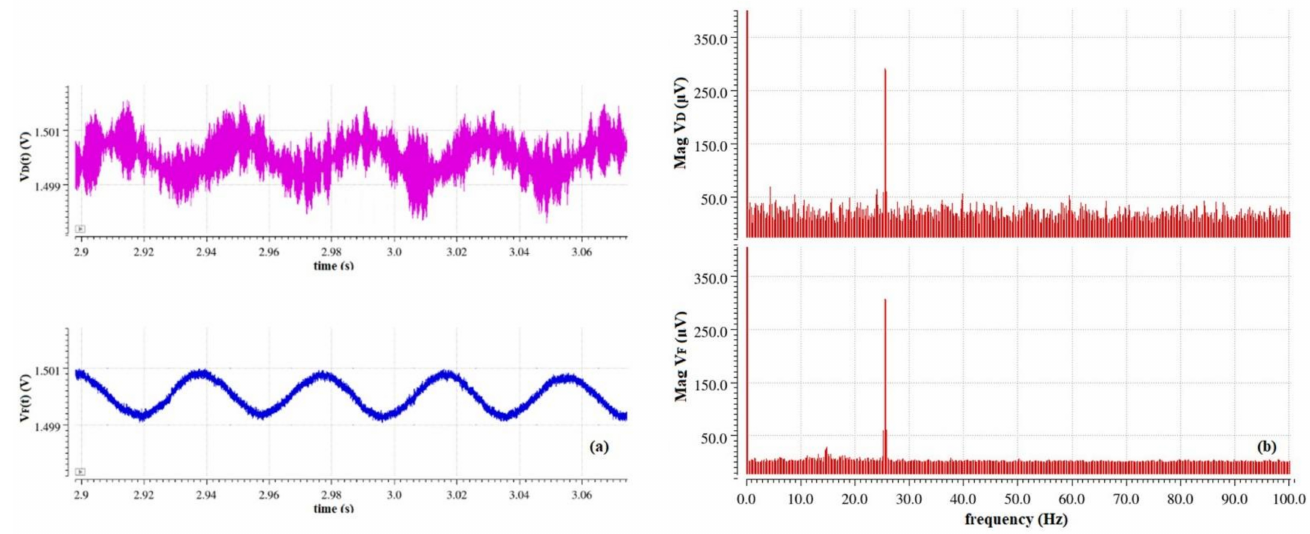
Figure 12. ( a ) Transient noise simulation of signal after I-V conversion and after filtering for E = 10 V/m; ( b ) FFT transform (Hanning window